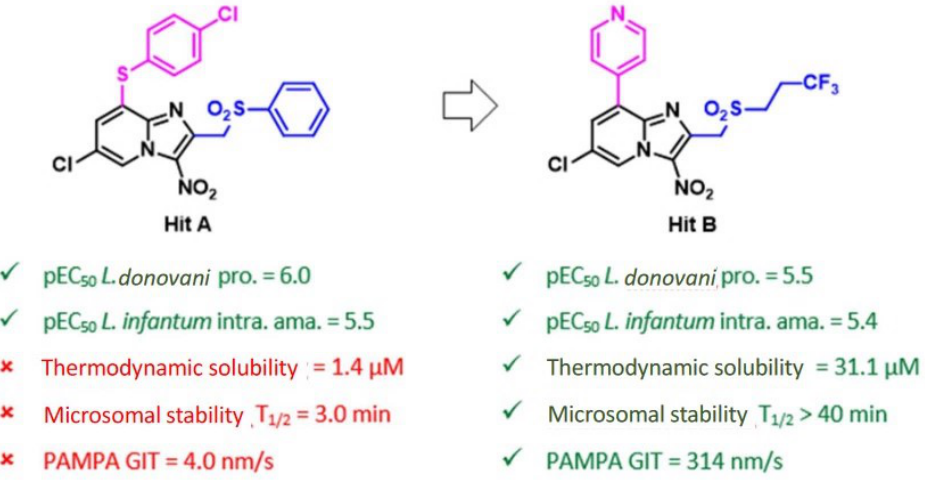
Figure 36. Improvement of in vitro physicochemical and pharmacokinetic properties of antileishma- nial hit compound in 3-nitroimidazo [1,2-a]pyridine